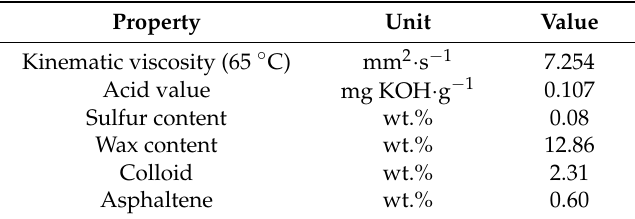
Table 1. Composition properties of crude oil.